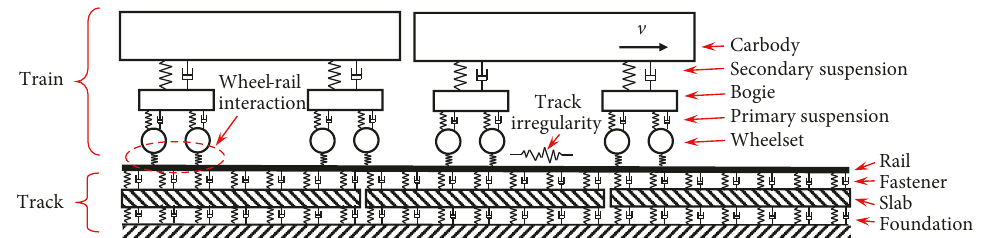
Figure 1: Typical train-track interaction model (slab ballastless track). Table 1: Main notations adopted in this